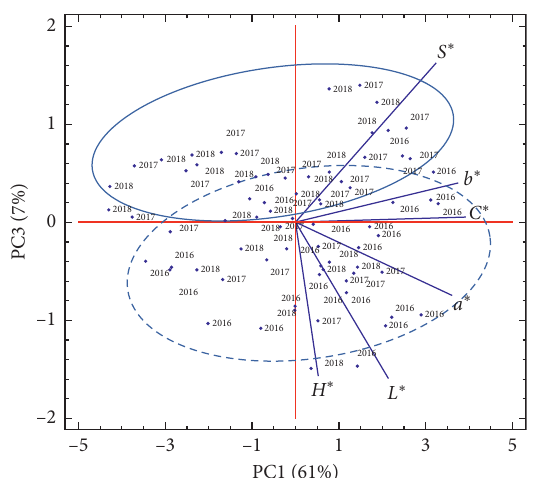
Figure 3: Principal component analysis (PCA) projections on PC1 and PC3. The eigenvalues are symbolized as blue segments rep- resenting traits that most affect each principal component. The 75 points plotted are cultivar mean values of each studied kernel color index: brightness index ( L ∗ ), redness index ( a ∗ ), yellowness index ( b ∗ ), chroma ( C ∗ ), hue angle ( H ∗ ), and metric saturation ( S ∗ ) of five almond cultivars grown in different sites of north-eastern Morocco (Aknoul, Bni Hadifa, Tahar Souk, Rislane, and Sidi Bouhria) during three growing seasons (2016 − 2018). 2016 � 2016 growing season, 2017 � 2017 growing season, and 2018 � 2018 growing